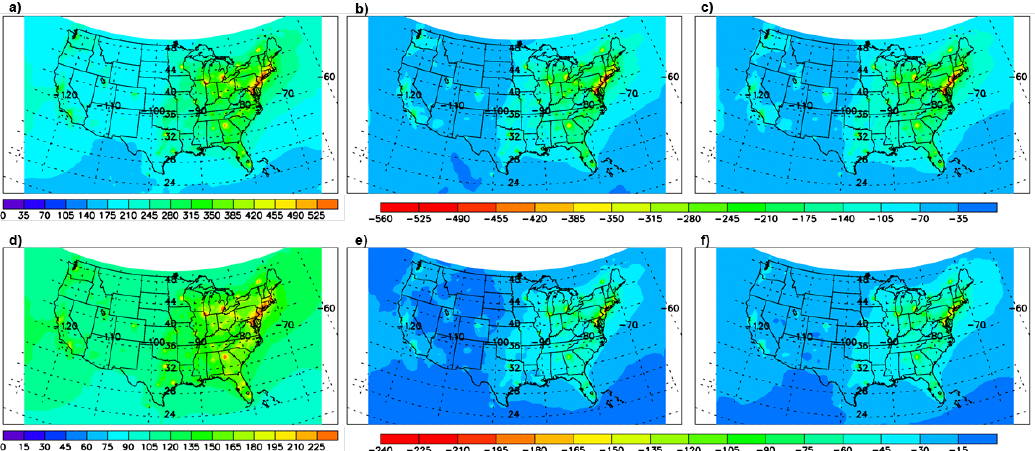
Figure 11. February 2050 averages CO concentrations (ppbv) simulated by CMAQ for the A1FI (top) and B1 scenarios (bottom). Each row contains the BL scenarios (left: a and d ), differences (ppbv) between the BL and H 2 -FC scenarios (center: b and e ), and differences (ppbv) between the BL and H 2 -ICE scenarios (right: c and f ). Data are from the lowest model level ( ∼ 100 m). Note that the scales are different among panels.